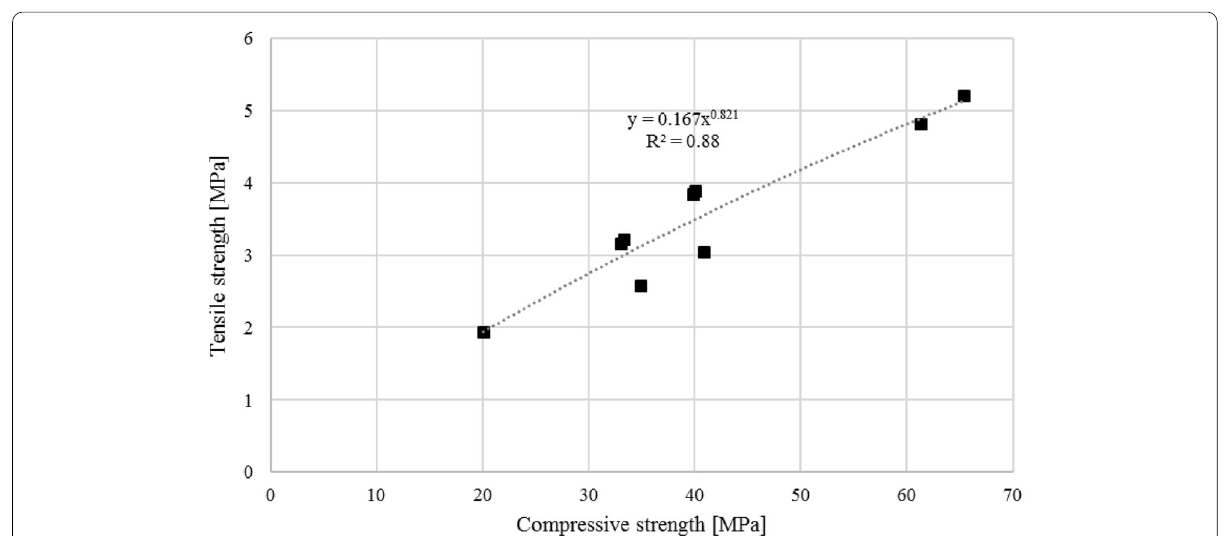
Fig. 3 Correlation between the tensile strength ( f t ) and the compressive strength ( f c